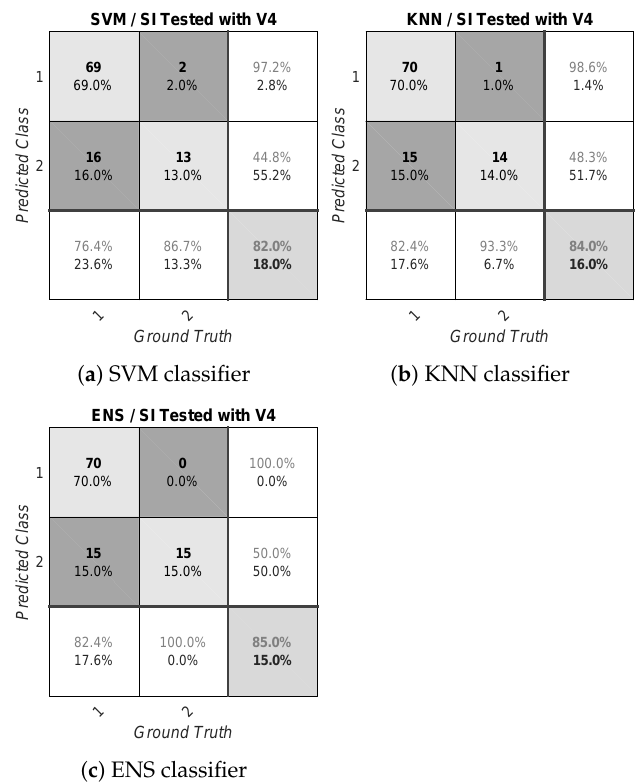
Figure A14. Confusion matrices for a subject-independent model tested with